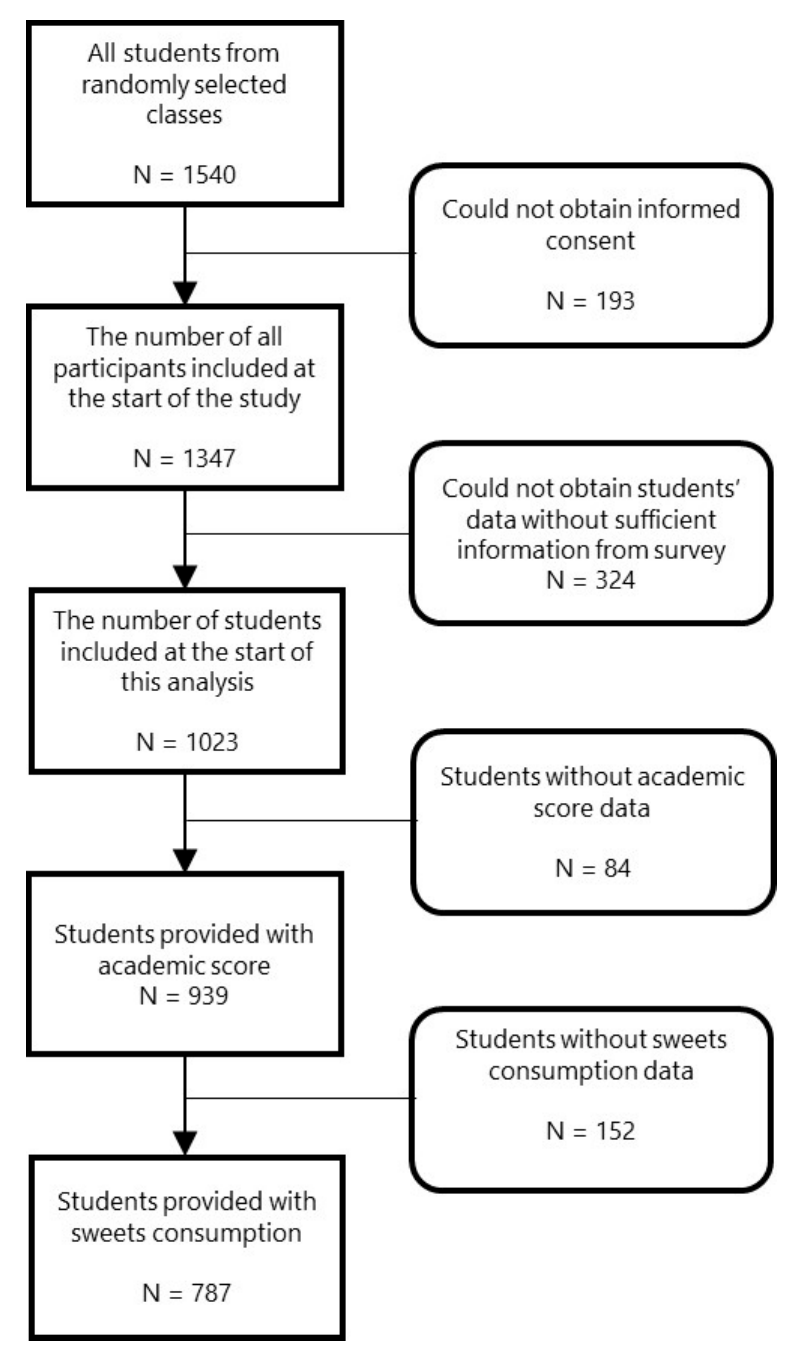
Figure 1. Flowchart for selecting participants in the study.